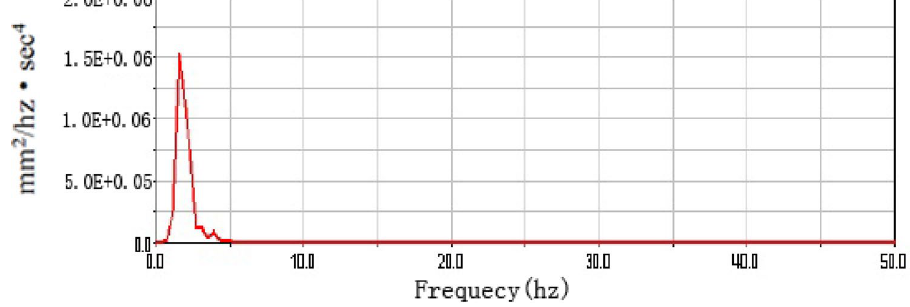
Fig. 7 Test 2. Acceleration Response Curve